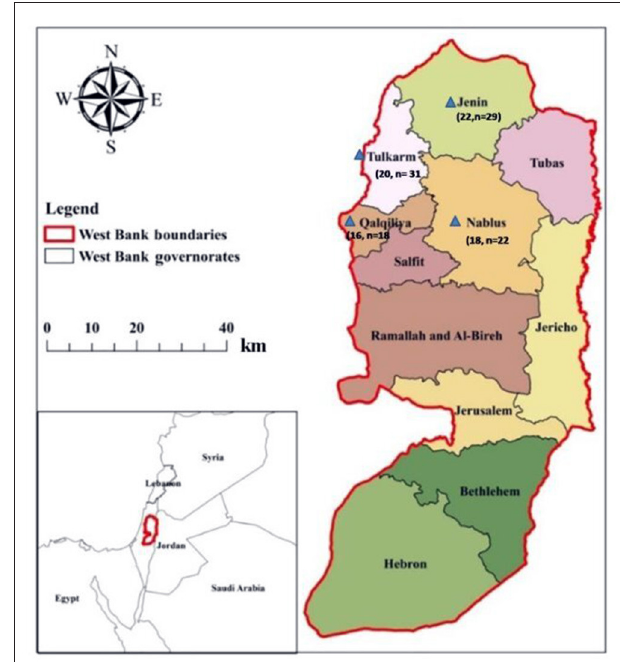
FIGURE 1 | Map of Palestine. Areas where the samples were collected. Numbers indicated by a blue triangle veterinarian’s collected and positive sample, respectively. Map adapted from reference